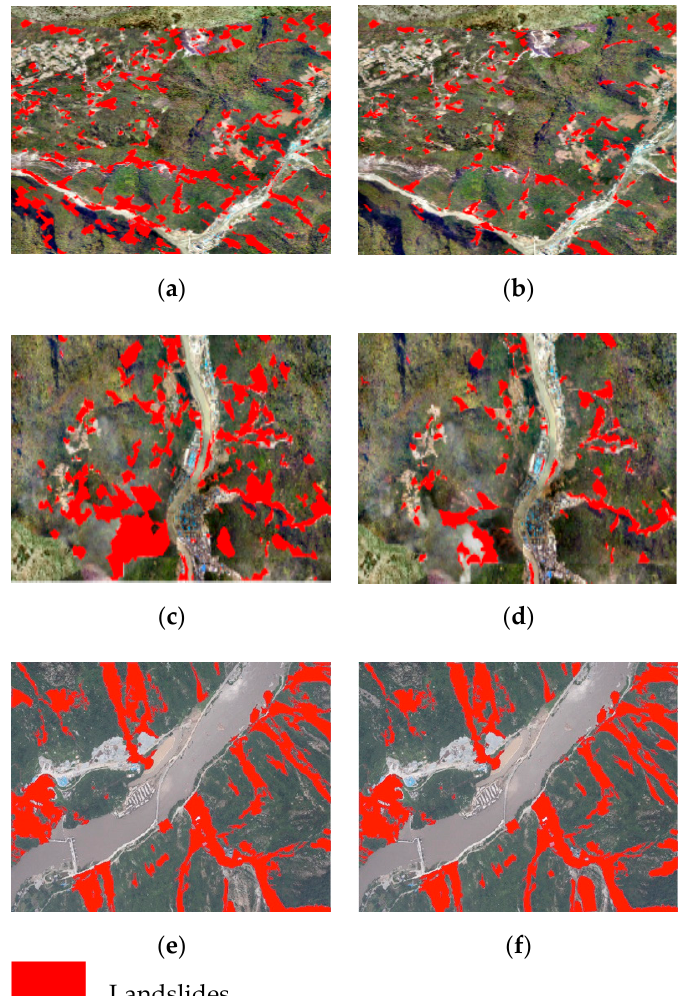
Figure 15. Results of landslide information extraction based on two methods. ( a ) Experimental image 1, based on NNC; ( b ) Experimental image 1, based on TLOEL; ( c ) Experimental image 2, based on NNC; ( d ) Experimental image 2, based on TLOEL; ( e ) Experimental image 3, based on NNC; and, ( f ) Experimental image 3, based on